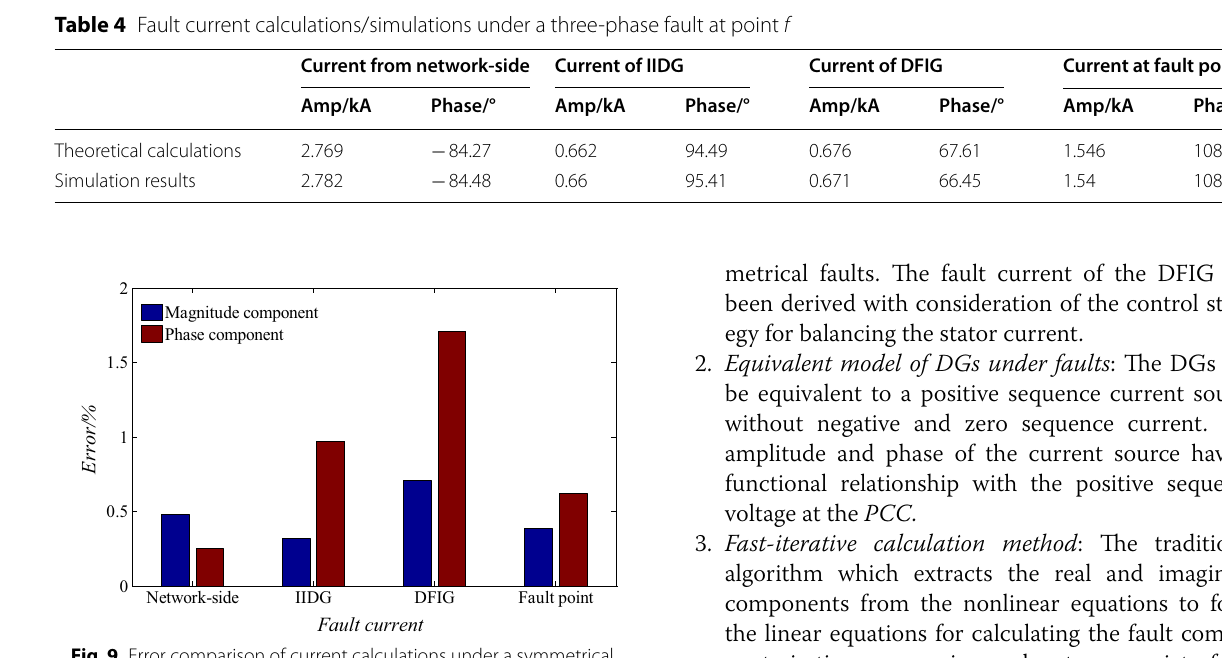
Fig. 9 Error comparison of current calculations under a symmetrical fault